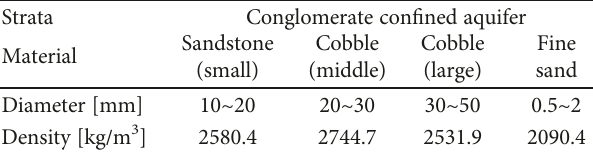
Table 1: Experimental materials of conglomerate-con fi ned